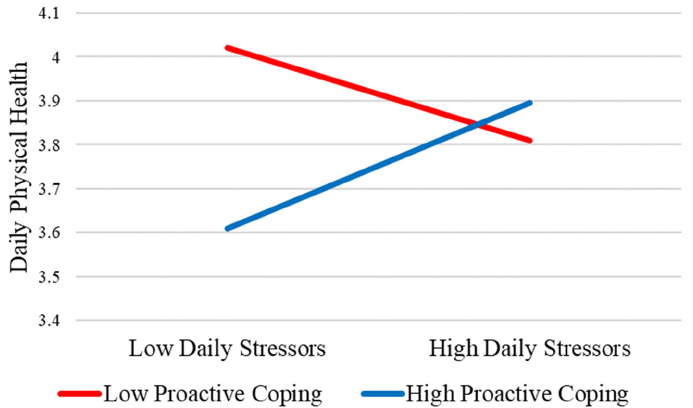
Figure 2. Significant 2-way interaction between daily stressors and proactive coping predicting daily physical health for younger adults (higher scores reflect better health). Predicted points were plotted with low ( M − 1 SD ) and high ( M + 1 SD ) proactive coping and low ( M − 1 SD ) and high ( M + 1 SD ) daily stressors, adjusted for all covariates. Younger adults low in proactive coping were more